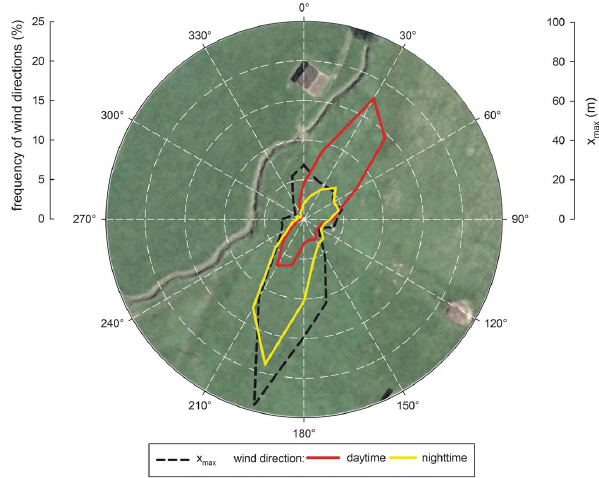
Fig. 1. Polar plot of the maximum of the footprint function x max (dashed black line) and the frequency the wind direction during daytime (red line) and nighttime (yellow line) overlaid on an aerial picture ( TIRIS , http://tiris.tirol.gv.at/) of the study